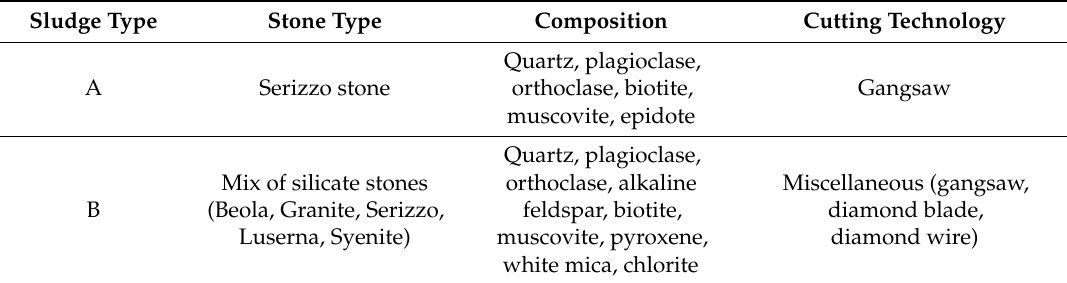
Table 1. General information on sawing